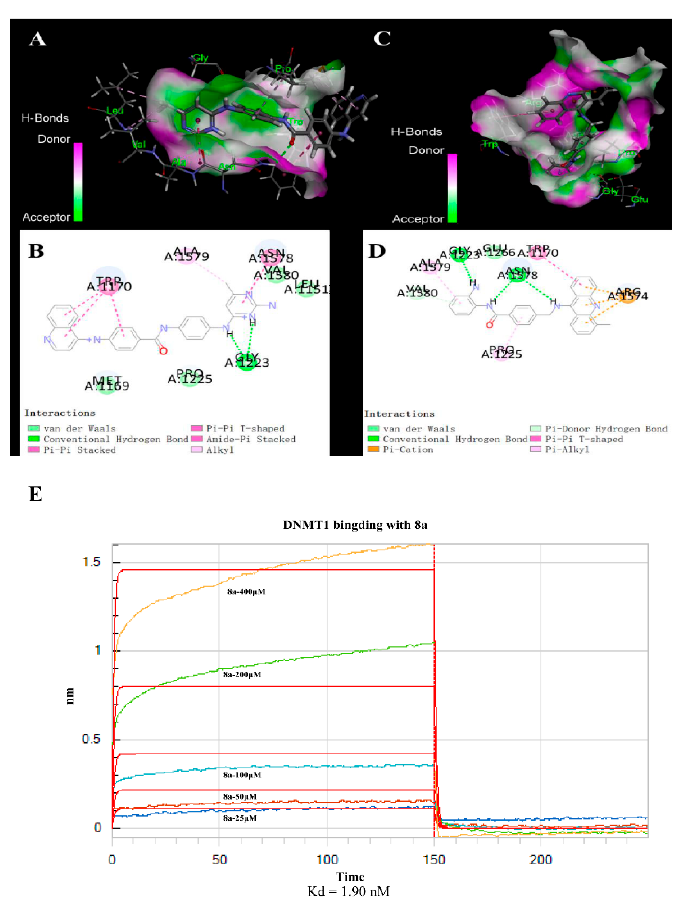
Figure 6. Molecular docking and interactions. ( A – D ) Docking modes of SGI-1027 ( A , B ) and 8a ( C , D ) with DNMT1. Semi-flexible docking: 3D and 2D docking diagrams made using Discovery Studio 2019 software. ( E ) The binding affinity between 8a and DNMT1 is based on biolayer interferometry (BLI). For DNMT1 combined with different concentrations of 8a (25, 50, 100, 200, and 400 µ M), the binding kinetics and dynamics were measured using an Octet K2 System (Forte Bio). The Kd (dissociation constant) value between 8a and DNMT1 protein was 1.90 nM.